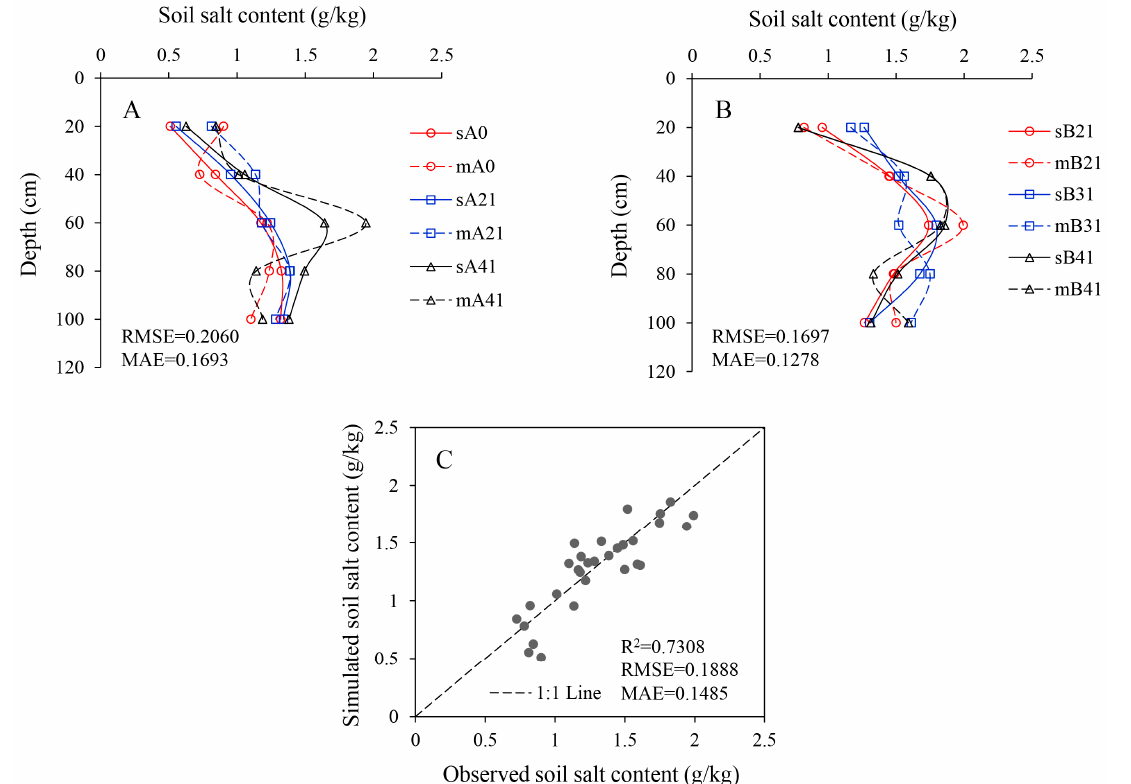
Figure 3. Plots of the results of calibration and validation analyses of the HYDRUS-ID model applied to the Hebei Low Plains study area in North China. Solid and dashed lines in A and B denote simulated and observed values, respectively; ( A , B ) are the calibrated and validated salt contents, respectively, at different soil depths at the time of the maize harvest; and ( C ) is the simulated and observed 1:1 goodness-of-fit line for the salt content at the time of the summer maize harvest.